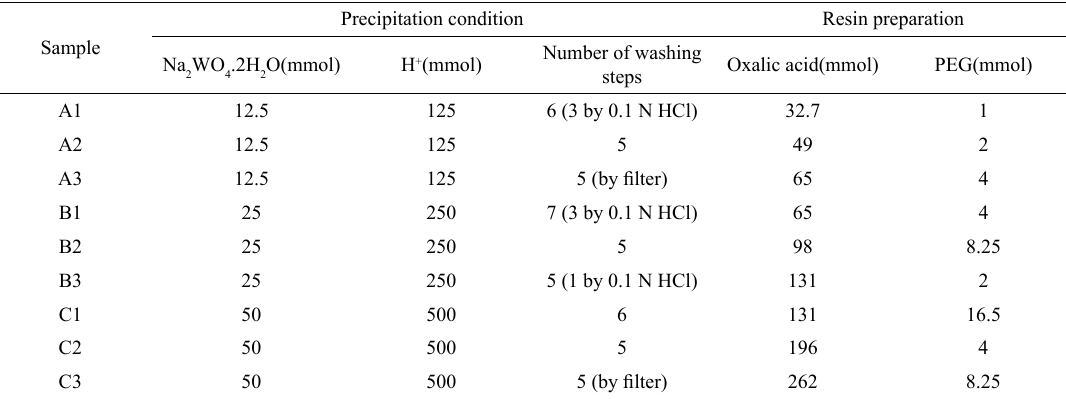
Table 1. Summary of different preparation conditions